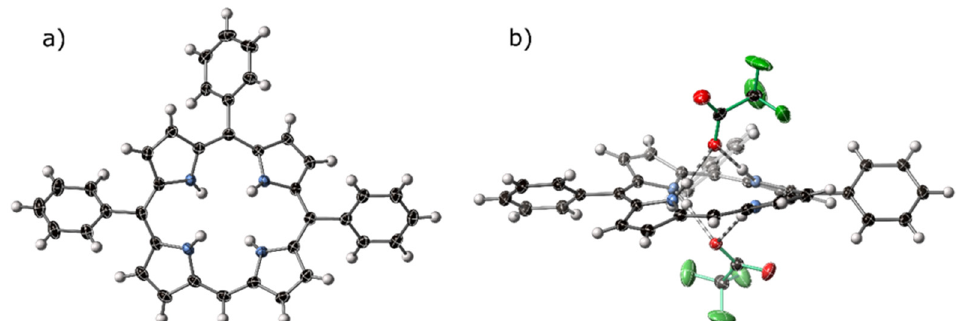
Figure 8. ( a ) A view of the porphyrin component of the crystal structure of [H 4 14 ][CF 3 CO 2 ] 2 . ( b ) Hydrogen-bonding bis-chelate to two trifluoroacetate anions within the crystal structure of [H 4 14 ][CF 3 CO 2 ] 2 . Trifluoroacetate anions are highlighted with green bonds, hydrogen bonds are indicated with striped bonds, thermal ellipsoids are drawn at 50%. 324